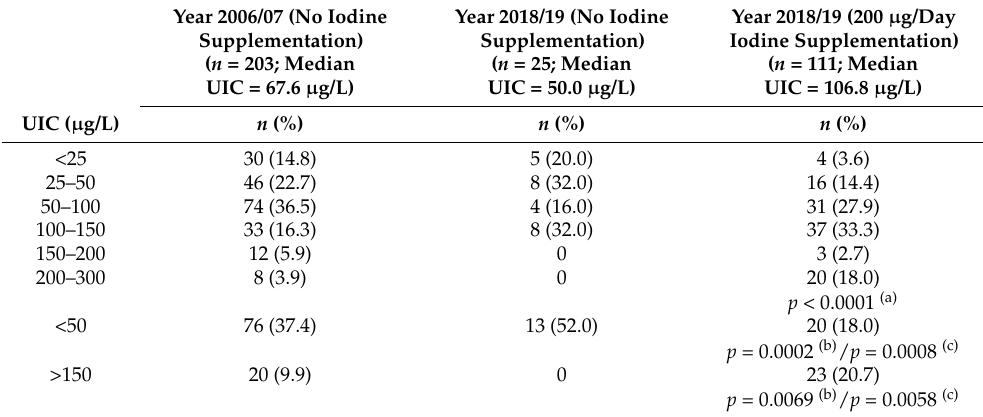
Table 1. Urinary iodine concentration (UIC) before (2006/07) and after (2018/19) the launch of national guidelines to promote iodine supplementation during